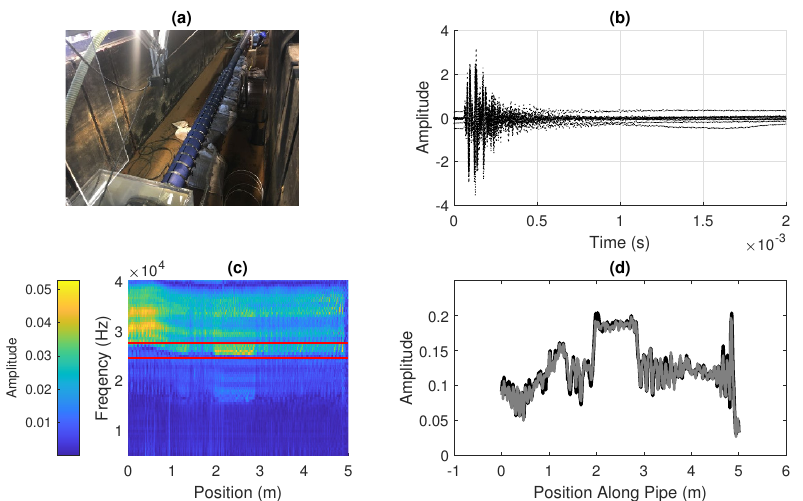
Figure 2. The experimental measurement of a spatially varying acoustic property along the length of a water pipe: ( a ) a photograph of the experiment at the University of Sheffield; ( b ) vibration time-response from points along a pipe, recorded using a hydrophone to excite the vibration and to record the response amplitude; ( c ) frequency spectra for a specific band (5 kHz to 40 kHz) for each position along a pipe, with the amplitude within a window (in this case 24.5 kHz to 27.5 kHz, shown by the red lines) summed to give a spatially varying signal along the pipe; and ( d ) the resulting spatially varying signal along the length of the pipe, where two sets of measurements are shown superimposed and it can be seen that the signal is largely the same in each